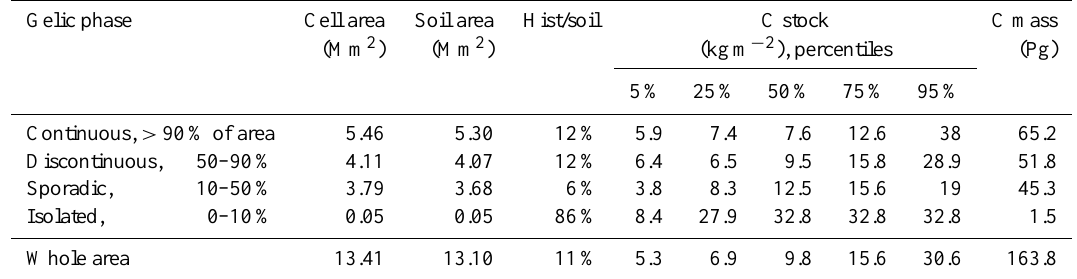
Figure 1. Global stock (a) and mass ( b , per 5 ◦ latitude) of organic carbon in the top 1m of the terrestrial soil calculated from HWSD v.1.1-adjusted. Table 4. Organic carbon mass (top 1m) of soils with gelic properties in HWSD v.1.1-adjusted (all areas north of 60 ◦ S). Percentiles refer to the distribution of C stocks in each cell within the soil area mentioned. 1Mm 2 = 10 6 km 2 . Hist/soil: fraction of soil area covered by